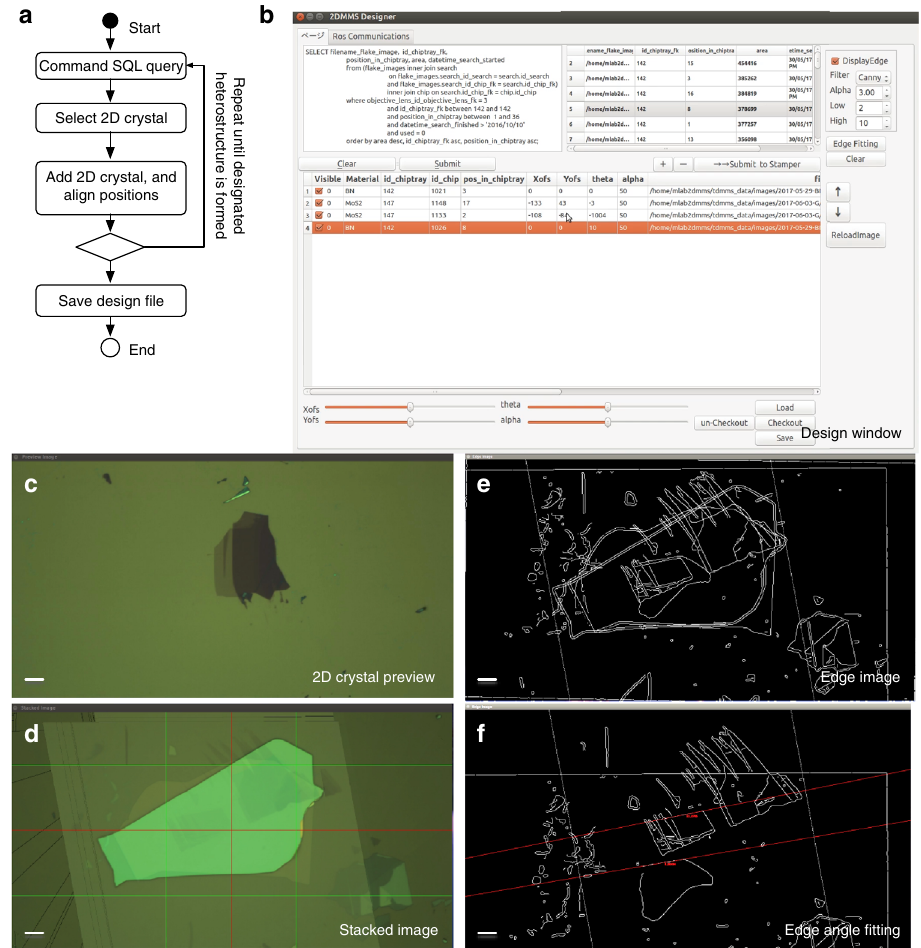
Fig. 5 The computer-assisted design of vdW heterostructures. a Operational fl ow diagram for designing vdW heterostructures. b – f Graphical user interface (GUI) window screenshots of our CAD software. b Main control window. c 2D crystal preview. d Edge image. e Stacked image. f Edge angle fi tting. The scale bars represent 10 μ